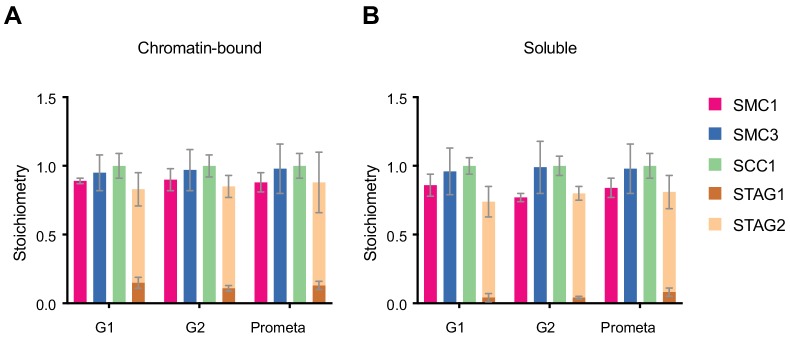
LC-MS quantification of cohesin subunit stoichiometry.Quantification of cohesin subunits in SCC1 immunoprecipitates from (A) chromatin or (B) soluble extracts isolated from G1, G2 or prometaphase synchronised HeLa cells. Numbers are normalised relative to SCC1 abundance. Data are plotted as mean ± standard deviation of two biological replicates and two technical replicates. For absolute values and exceptions, see Appendix 1—table 2. For individual peptide counts, see Figure 1—figure supplement 4.